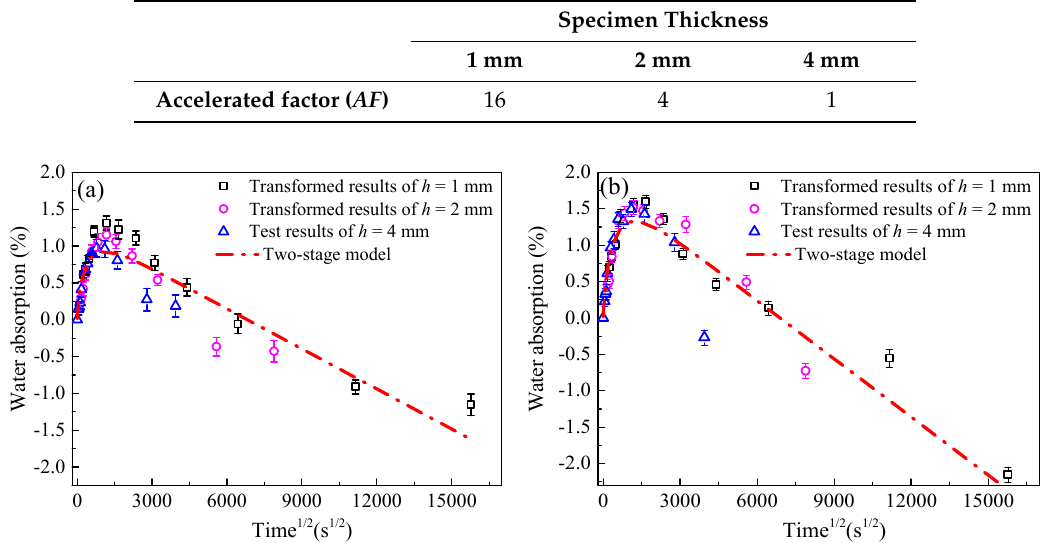
Table 3. The accelerated factor AF of BFRP laminates with di ff erent thicknesses.